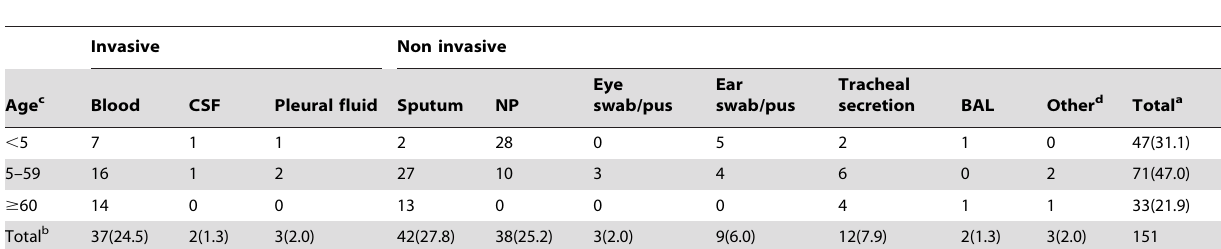
Table 2. Distribution of pneumococcal isolates based on age groups against the clinical sites of isolations.